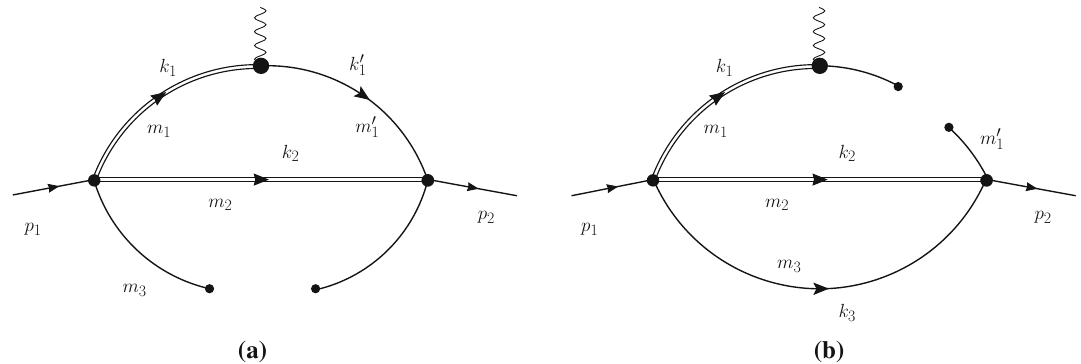
Fig. 4 Light-quark condensate diagrams. The heavy quark will not condensate and thus only the two light-quark propagators give condensate